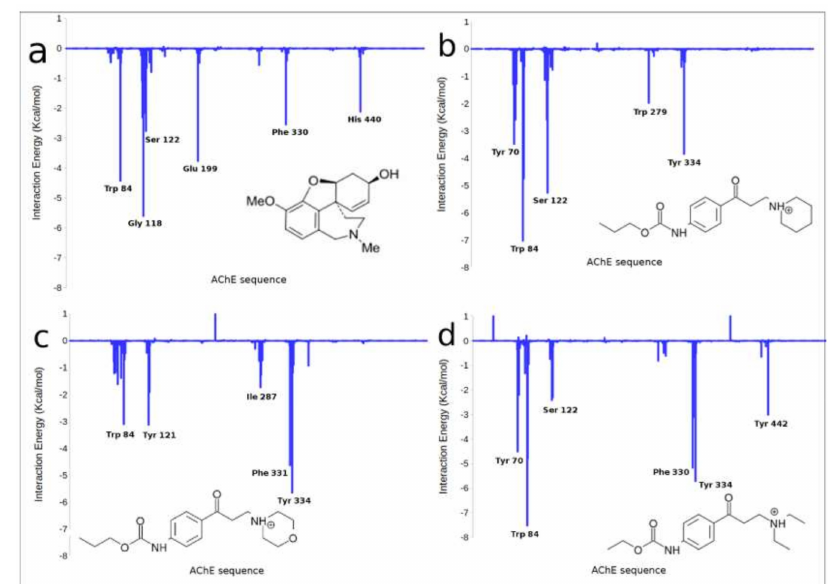
Figure 2. Histograms of interaction energies partitioned with respect to the AChE amino acids in complex with galantamine ( a ), compounds 3 ( b ), 5 ( c ) and 6 ( d ). The x-axis denotes the residue number of AChE, and the y-axis denotes the interaction energy between the compounds and specific residue. The negative values and positive values are favorable or unfavorable to binding,